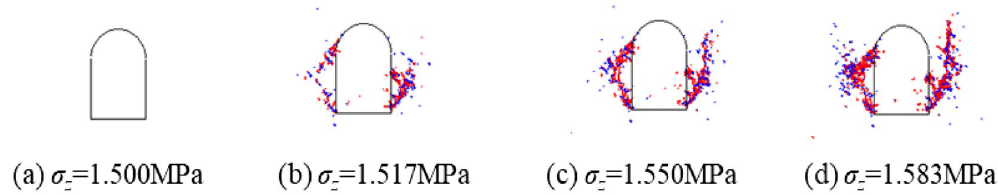
Figure 23. Damage propagation during excavation unloading with imposed vertical stress of 1.500